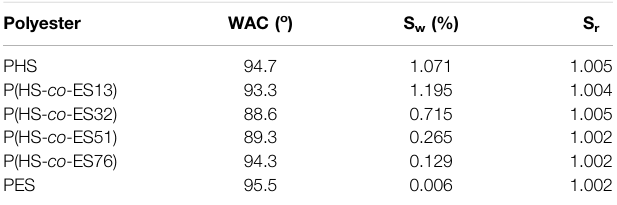
TABLE 3 | Water contact angle, degree of swelling, and swelling ratio of the polyesters.